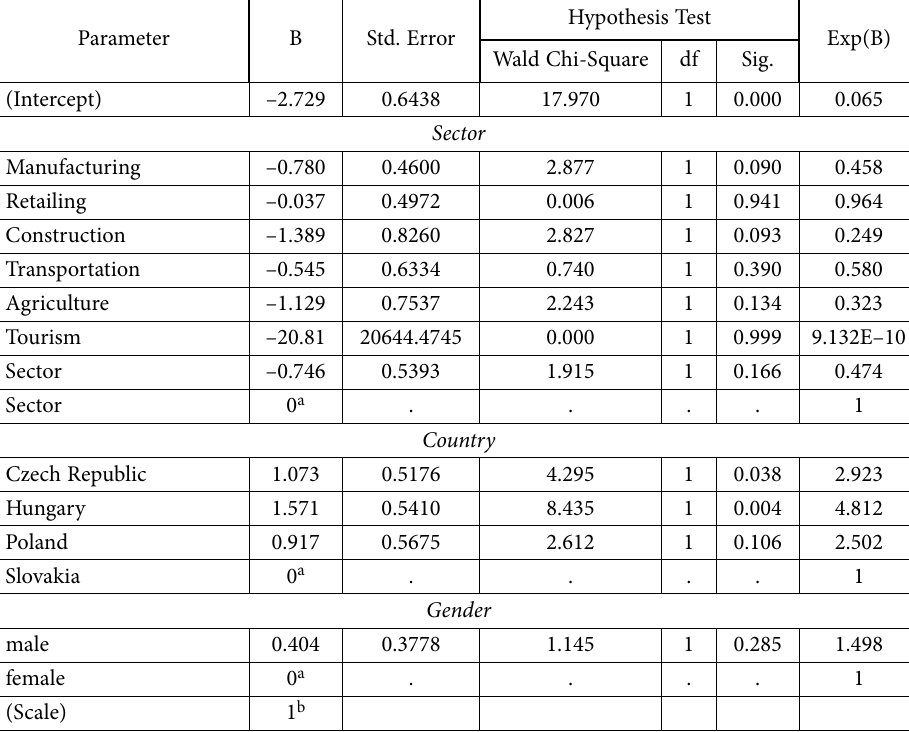
Hypothesis Test Sig.